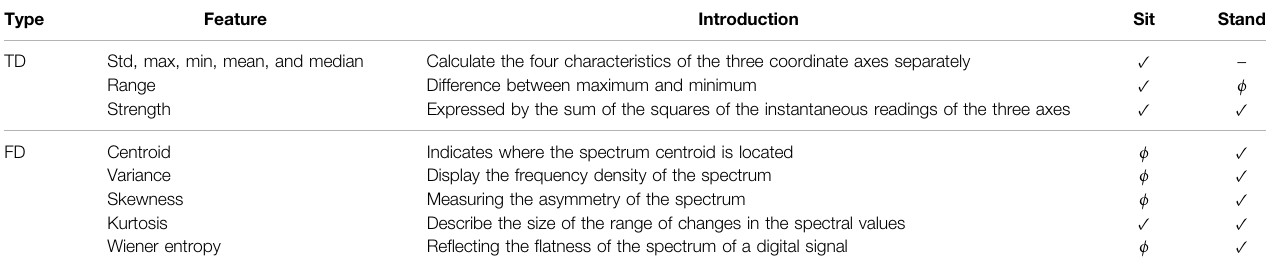
TABLE 2 | Type of feature extracted from the signal. “ ✓ ” means that all the features are used, “ ϕ ” means none is used, and “ − ” means partially used.